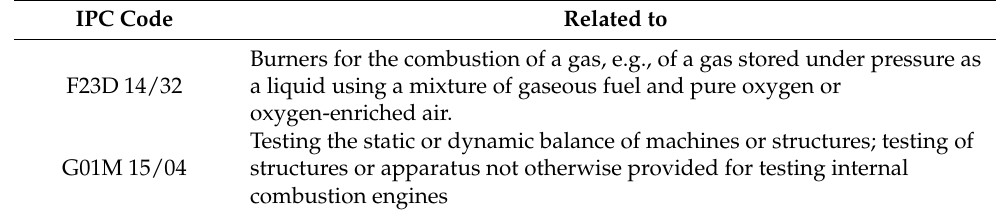
Table 1. IPC codes used in the present patent technology